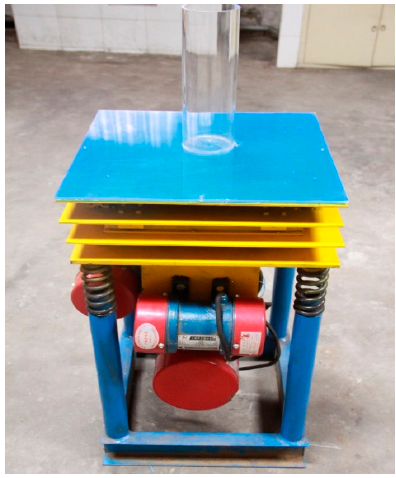
Figure 3. Image of three-dimensional vibration test rig.